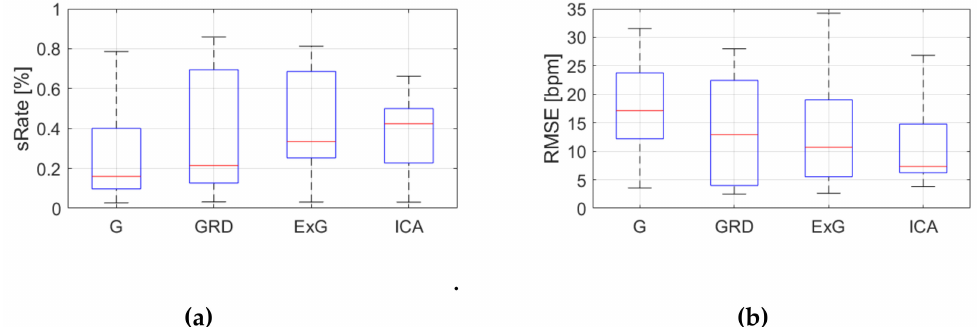
Figure 14. Comparison of signal extraction methods, algorithm No.2 (AR), part 2: ( a ) box plots for sRate ; ( b ) box plots for RMSE . Blue lines—IQR range, red line—median value.